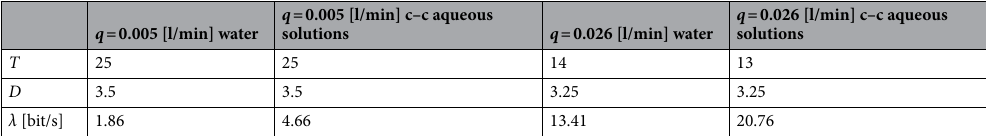
Table 2. Values of time delay, correlation dimension, and Lyapunov exponent calculated using the pressure fluctuations in the gas supply system at various flow rates and for both water and c–c aqueous solutions.